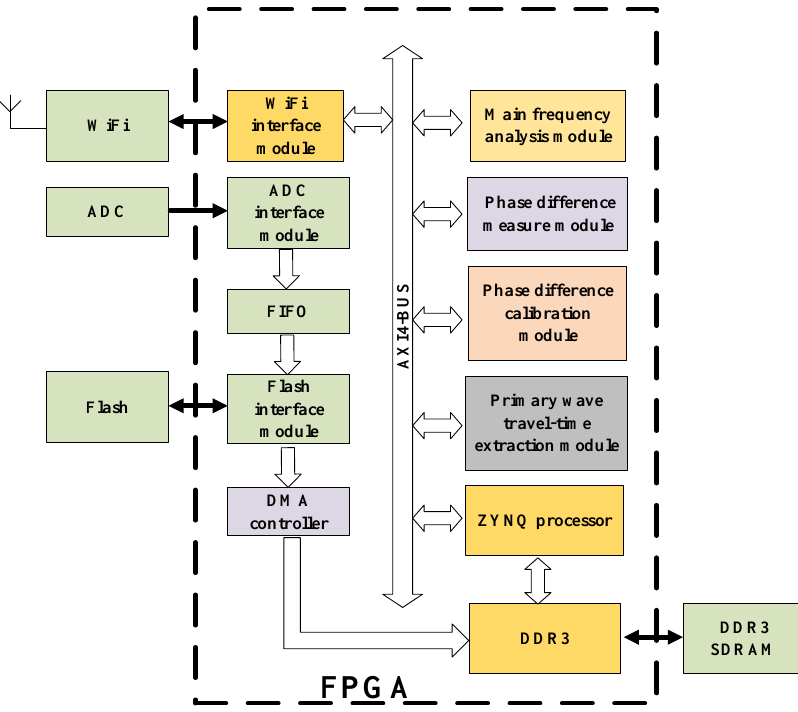
Figure 7. Overall schematic diagram of FPGA top layer design.